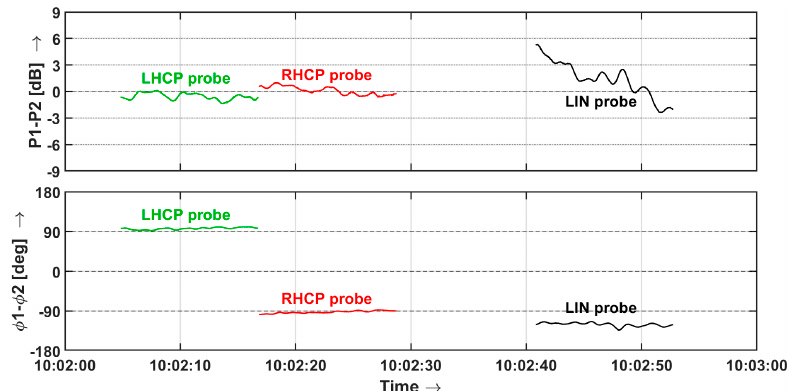
Figure 13. Polarization of a sequence of probing signals captured by the sensor during normal NVIS